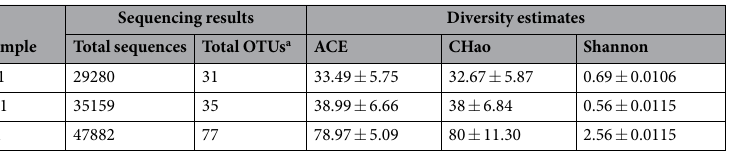
Table 3. MiSeq sequencing results and diversity estimates for each sample a . a: m1, Br1 and T1 are shorts for the midgut samples from deltamethrin-susceptible population, deltamethrin-resistant population and field-caught population of Plutella xylostella , respectively.